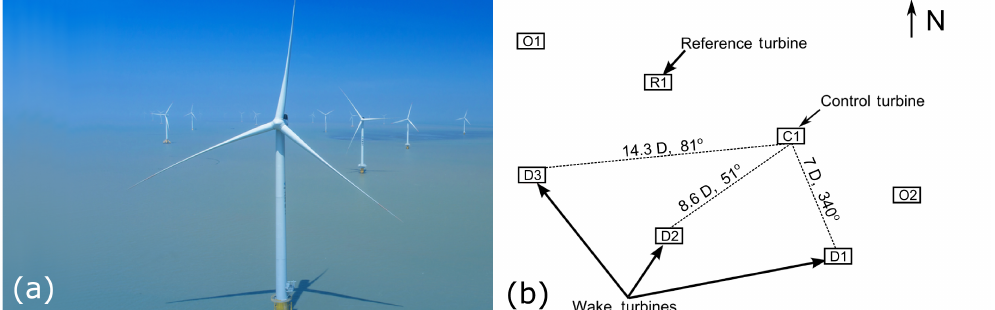
Figure 2. (a) Rudong wind farm used in the field study. (b) Turbine locations. The wake-steering control strategy is implemented to mitigate the wake interactions between C1, on the one hand, and D1, D2, and D3, on the other. As indicated by the diagram, C1 is the control turbine, R1 is the reference turbine, and D1, D2, and D3 are downstream turbines waked by C1. Turbines O1 and O2 are other turbines not directly used in the study but whose wakes are noticed in certain